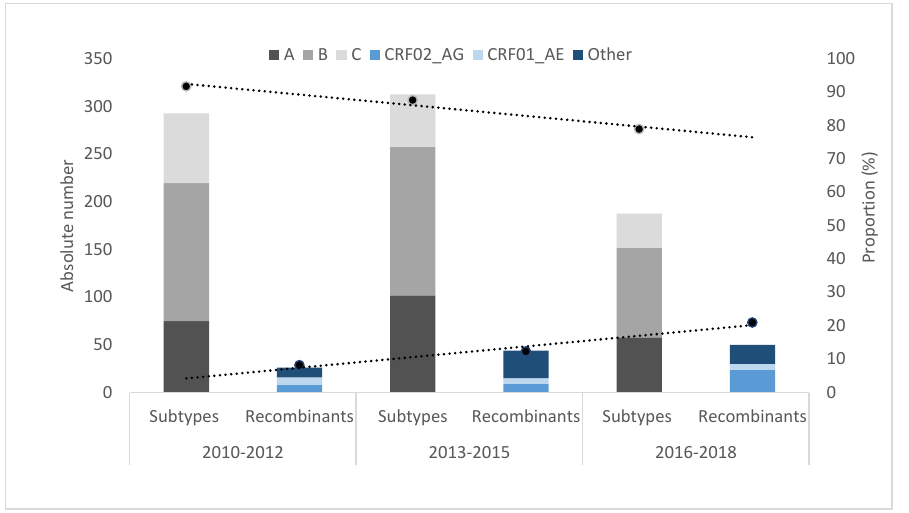
Figure 4. HIV-1 subtypes versus recombinant forms by years of diagnosis 2010 – 2012, 2013 – 2015, and 2016 – 2018. Number of HIV-1 subtypes is presented by black-grey columns (subtype A — dark grey, B — lighter grey, and C — very light grey). Recombinant forms are in blue colors (CRF02_AG in light blue, CRF01_AE in lighter blue, and all other recombinants in dark blue). Black dotted lines denote the trend in the proportion of HIV-1 subtypes and recombinants.